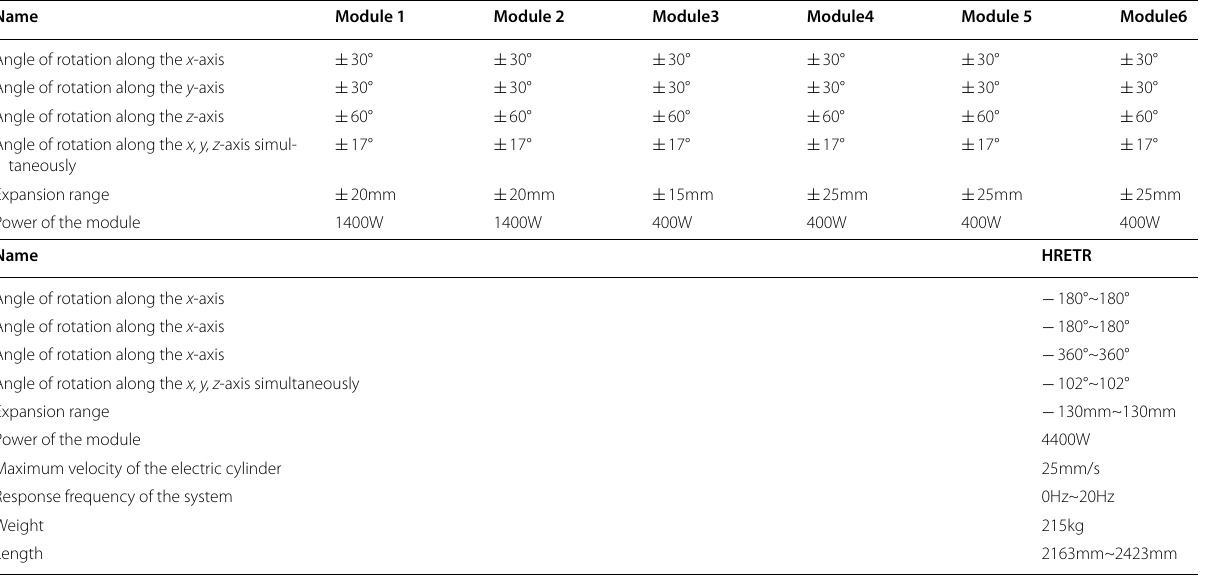
Table 4 Performance parameters of the